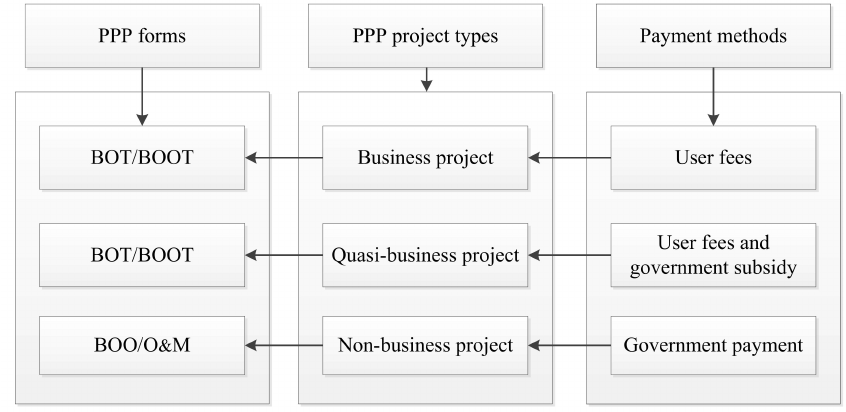
Figure 1. The PPP forms from the NDRC (2014) in